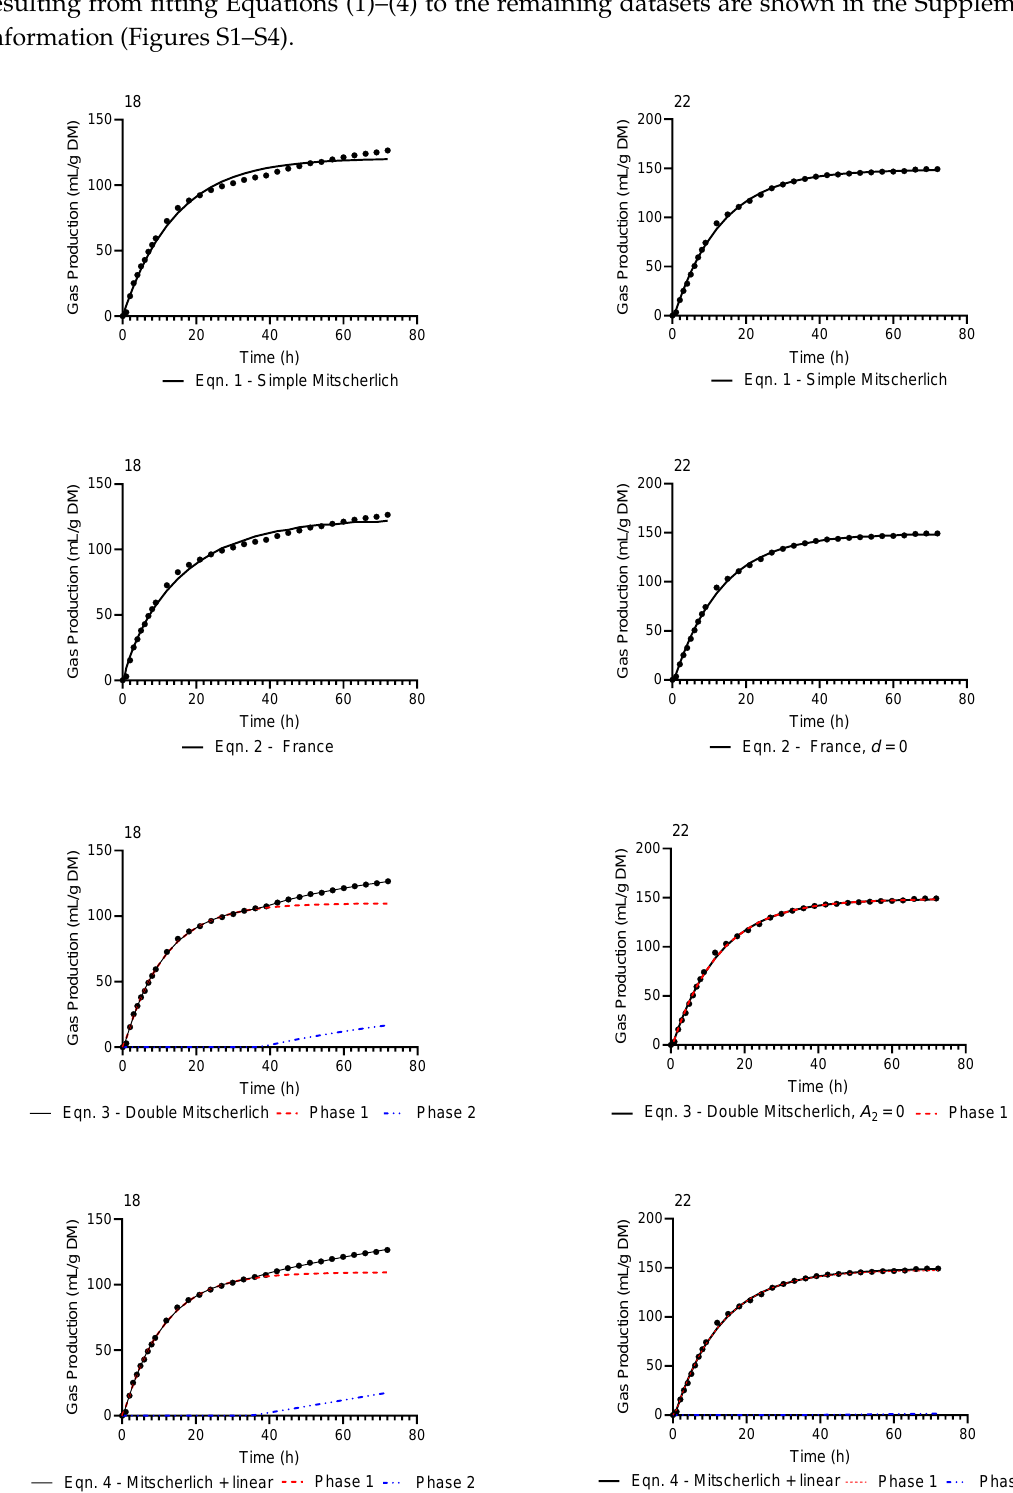
Figure 2. Observed ( • ) typical gas production profiles and predicted curves resulting from fitting Equations (1)–(4) to Dataset 18 and 22 of Experiment 2.